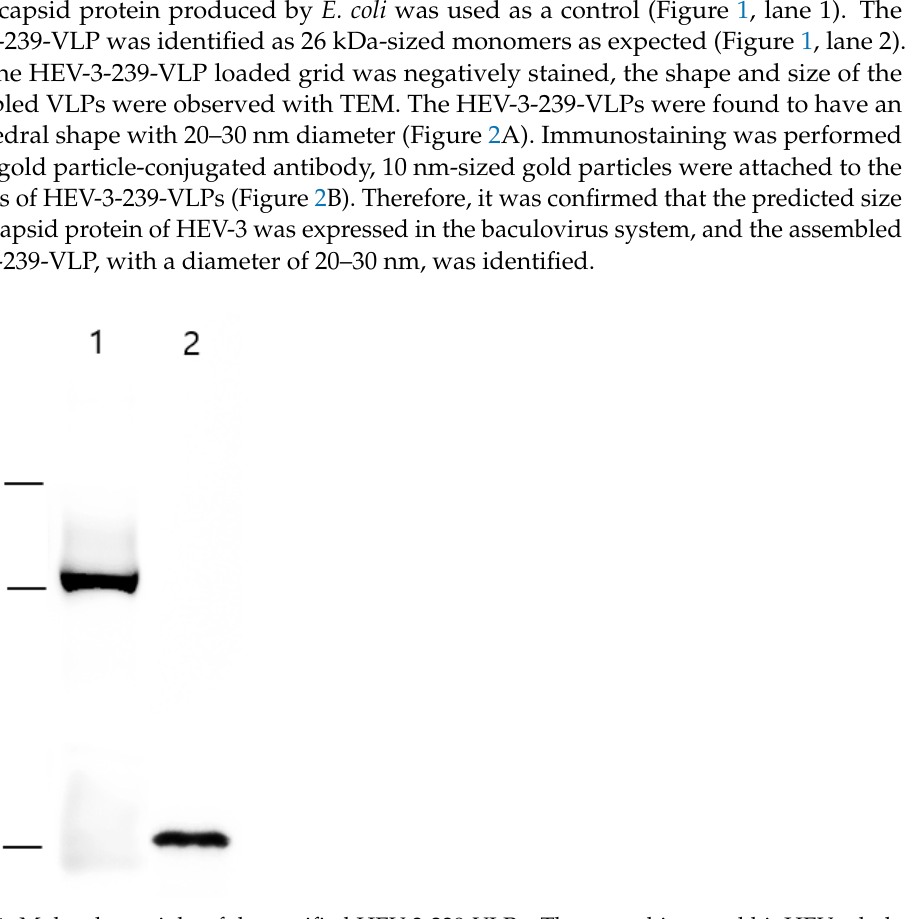
Figure 2. Electron microscopy images of the assembled HEV-3-239-VLPs. ( A ) Electron micrographs of negative stained HEV-3-239 VLPs. The diameter of the assembled VLP is 20 – 30 nm; ( B ) electron micrographs of the immunostained HEV-3-239 VLP. Gold particles with a size of 10 nm were at- tached to the VLPs. 3.2. Fecal Viral Shedding and Viremia Were Not Detected in the Pigs Vaccinated with 200 μg of VLPs The first vaccine inoculation was administered at week 0, and the booster shot was administered at week 2 in both the vaccinated groups. At week 4, the vaccinated group and the positive control group were challenged with the swine HEV-3. At week 10, the pigs were euthanized, and the livers were collected. The RNA of HEV-3 failed to be de- tected in all the sera and fecal samples collected every week of the experiment from pigs in the negative control group, as expected. In contrast, the pigs in the positive control group showed viremia from weeks 6 to 9, and fecal viral shedding from weeks 6 to 10